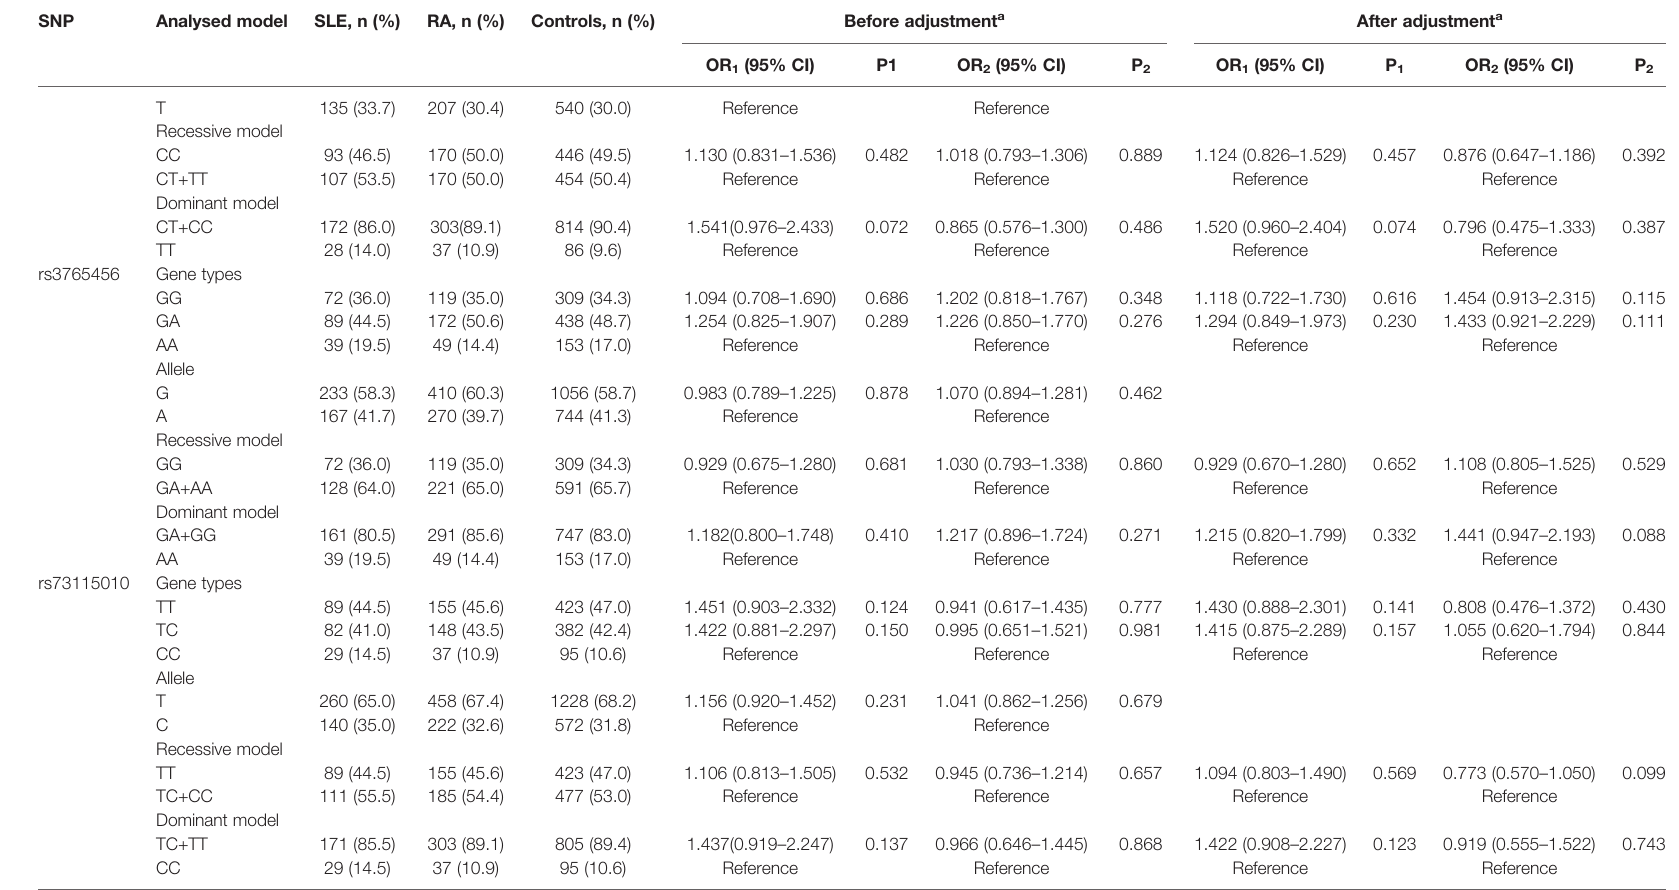
Description of alleles, genotypes of the six polymorphisms in SLE patients and healthy controls was listed as frequency, percentage. Differences of alleles, genotypes of the six polymorphisms between SLE patients and healthy controls were analyzed by chi-square test. Logistic regression calculated (adjusted) odds ratio and 95% con fi dence interval. Software SPSS 17.0 was used for the